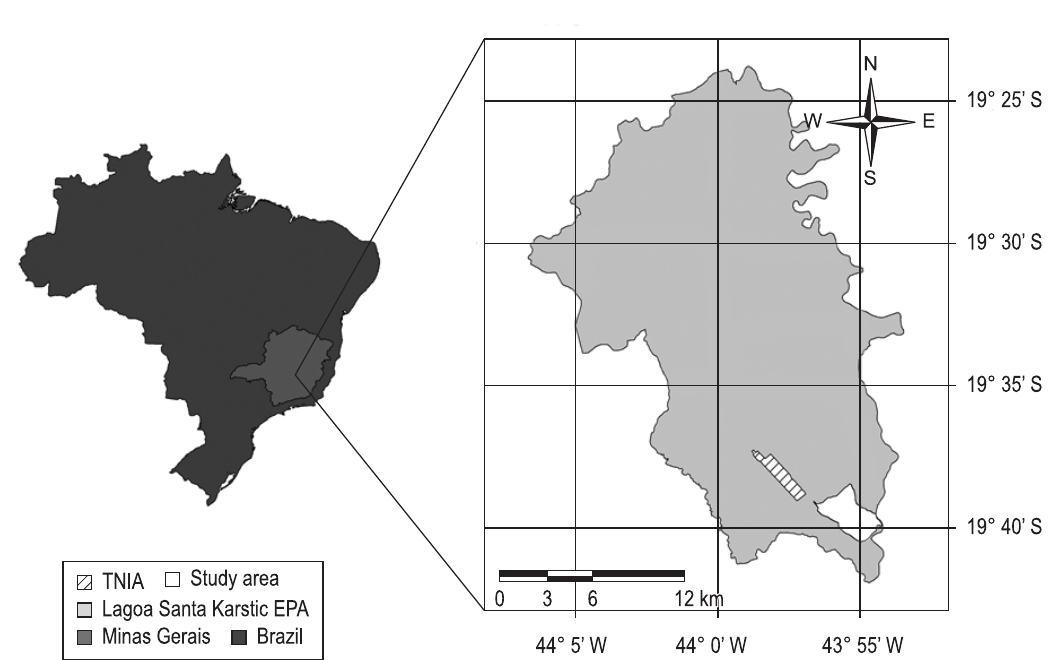
Figure 1. Location of the study